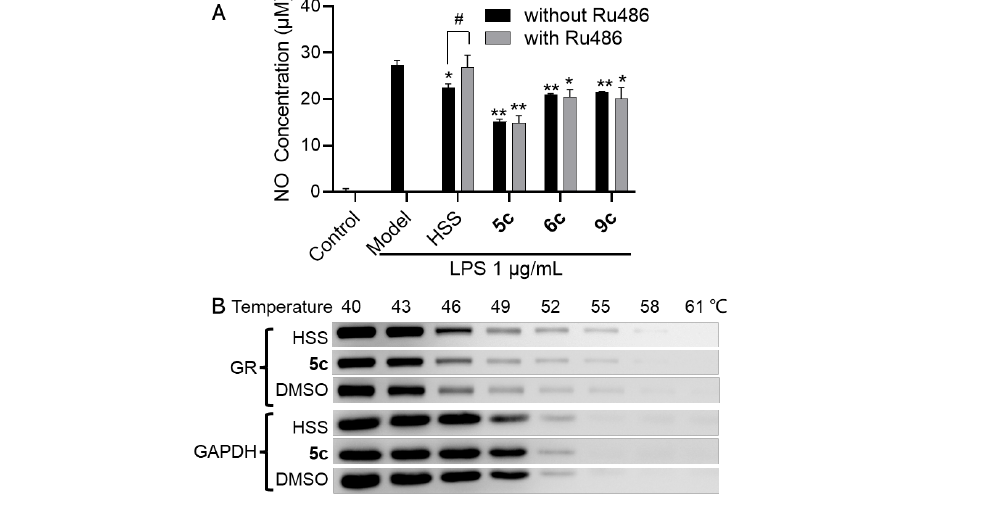
Figure 7. The GR-independent effect of derivative 5c on its anti-inflammatory activity: ( A ) Effect of Ru486 (a specific GR antagonist) on the NO inhibitory effects of 12-dehydropyxinol derivatives. After pretreatment with the test compounds (20 μM) in the presence or absence of Ru486 (10 μM) for 2 h, the macrophages were treated with LPS (1 μg/mL) for another 24 h. Data are expressed as the means ± SD ( n = 3): * p < 0.05, ** p < 0.01 vs. model; # p < 0.05 vs. without Ru486 group. ( B ) CESTA assessment of derivative 5c in RAW264.7 macrophages. Immunoblotting results for GR thermal aggregation curves from samples treated with 5c (20 µ M), HSS (20 µ M), or DMSO as a